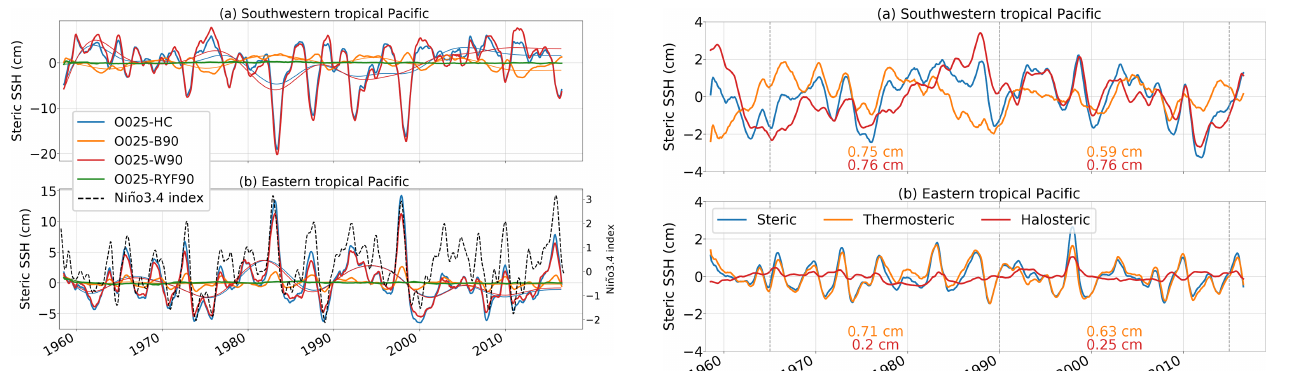
Figure 6. Time series of steric SSH anomalies from O025-B90 aver- aged over boxes in the (a) southwestern and (b) eastern tropical Pa- cific. Exact areas are shown as boxes 1 and 2 respectively in Fig. 4. Standard deviations for thermosteric and halosteric SSH anomalies are given for the periods from 1965–1990 and 1990–2015. All time series are smoothed with a 12-month running